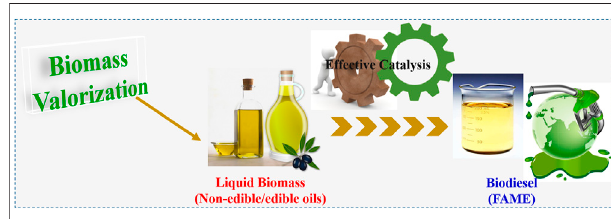
FIGURE 1 | Schematic illustration of catalytic conversion of liquid biomass into